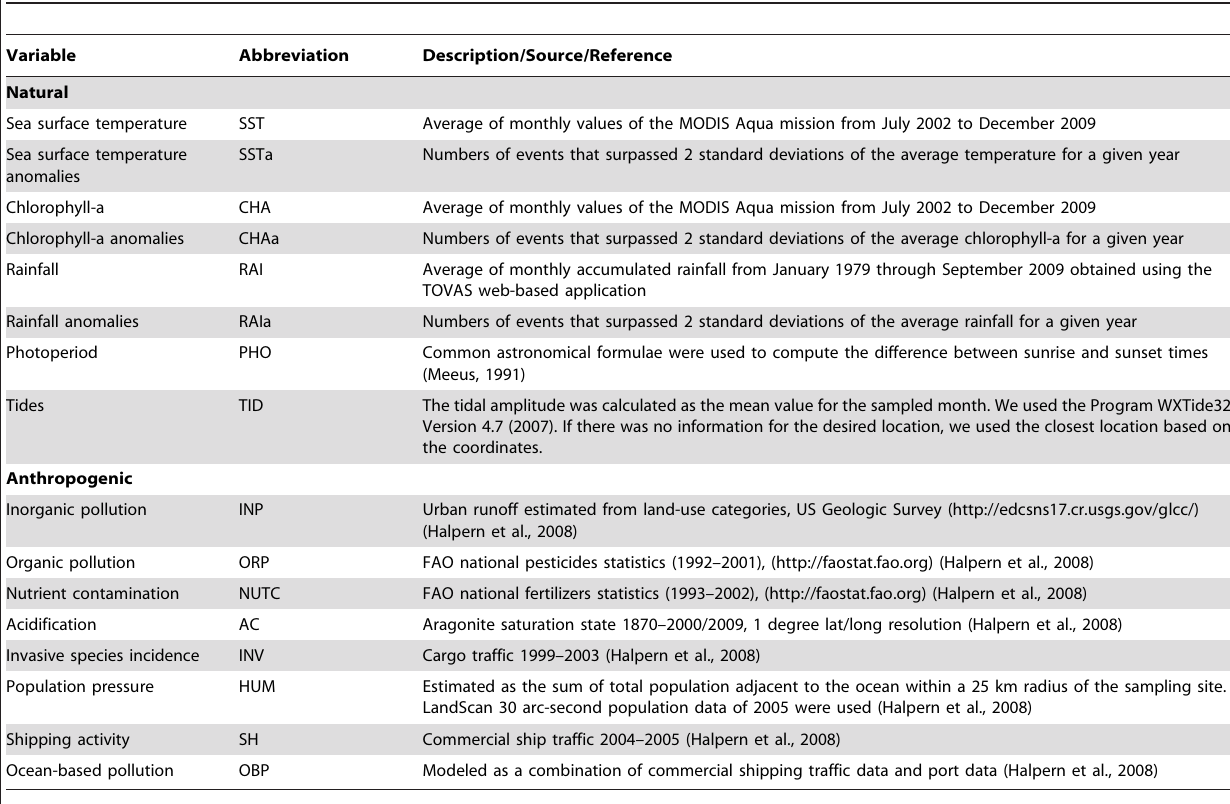
Table 2. List and sources of the natural and anthropogenic variables used in the